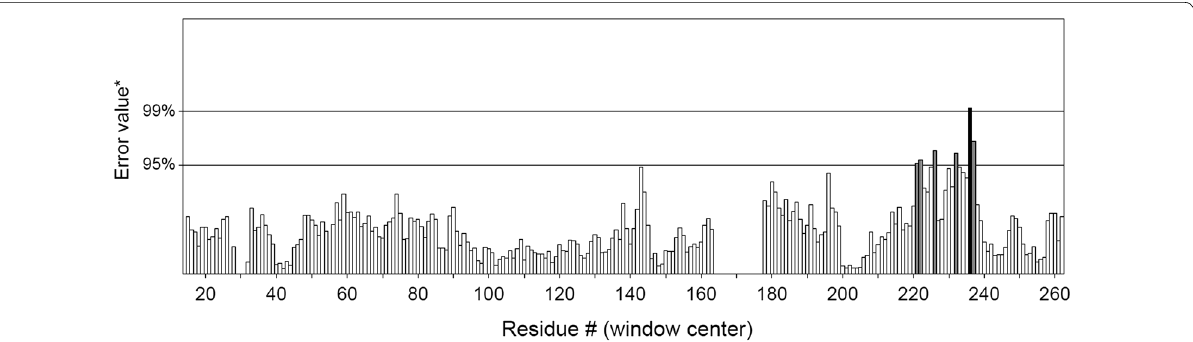
Fig. 3 ERRAT plot for measurement of the structural errors